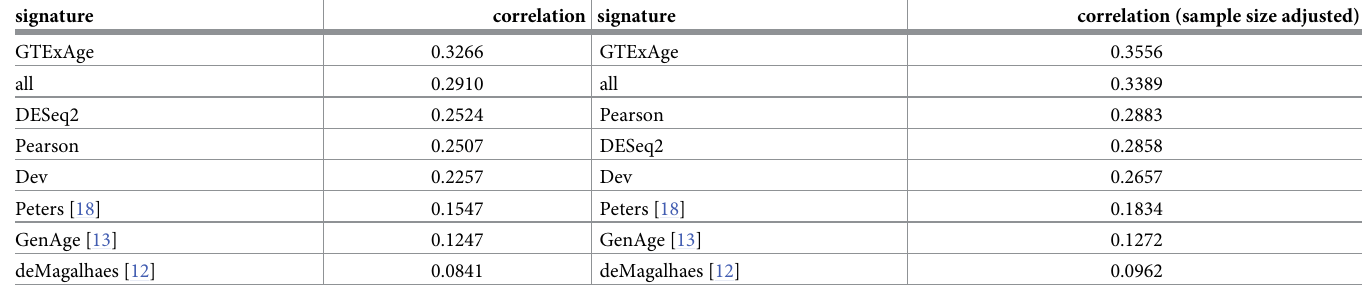
Table 1. Performance evaluation based on average Pearson correlations across tissues for each candidate feature